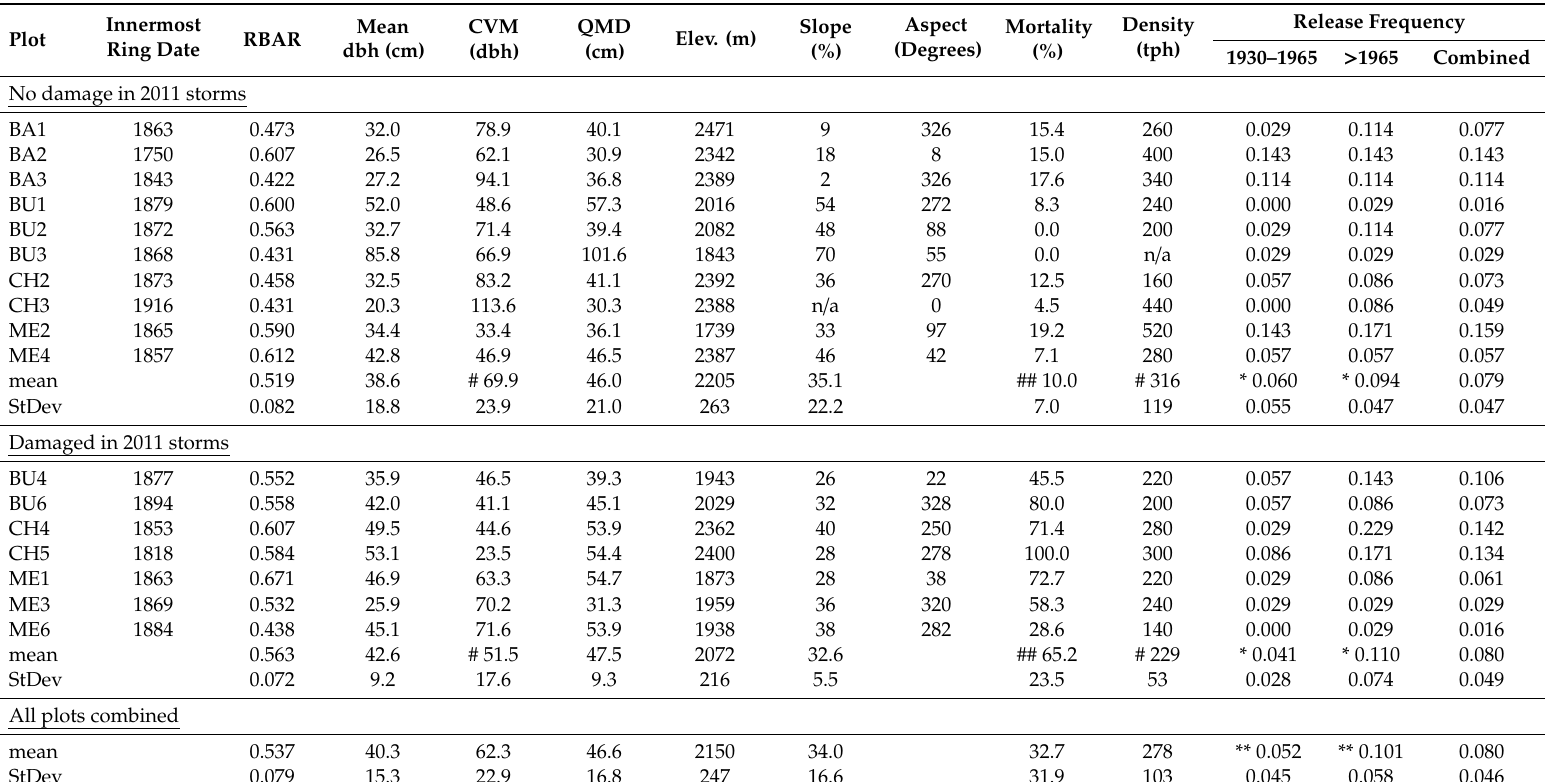
Table 1. Site and chronology descriptive variables, and growth release frequencies for sites with and without wind damage from the 2011